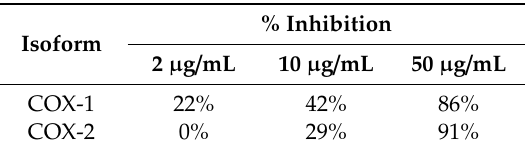
Table 2. COX-1 and COX-2 inhibition from